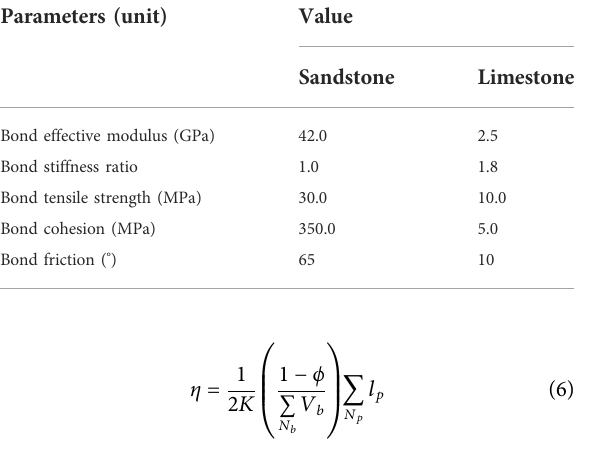
TABLE 2 Different rock microscopic